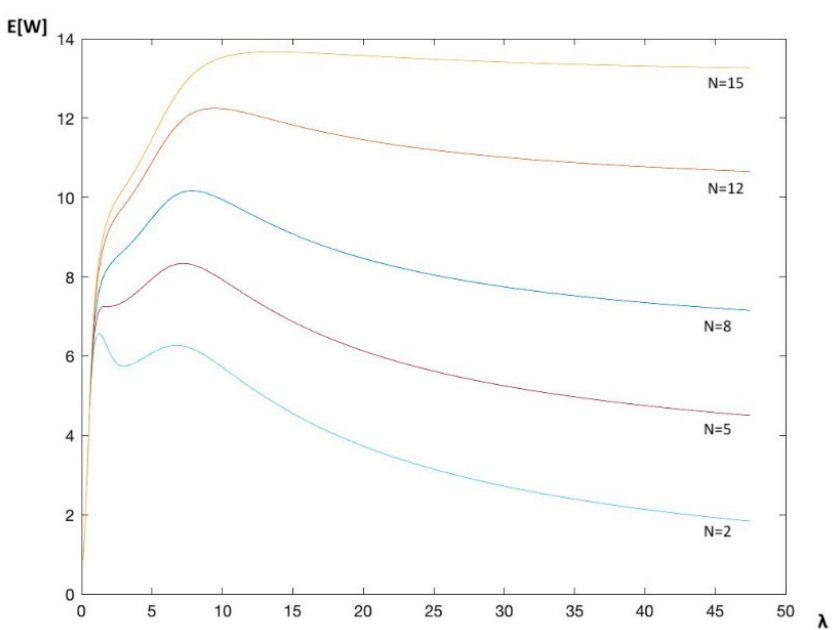
Figure 2. Mean waiting time for variable input rate of a bursty source for different values of 𝑁 .